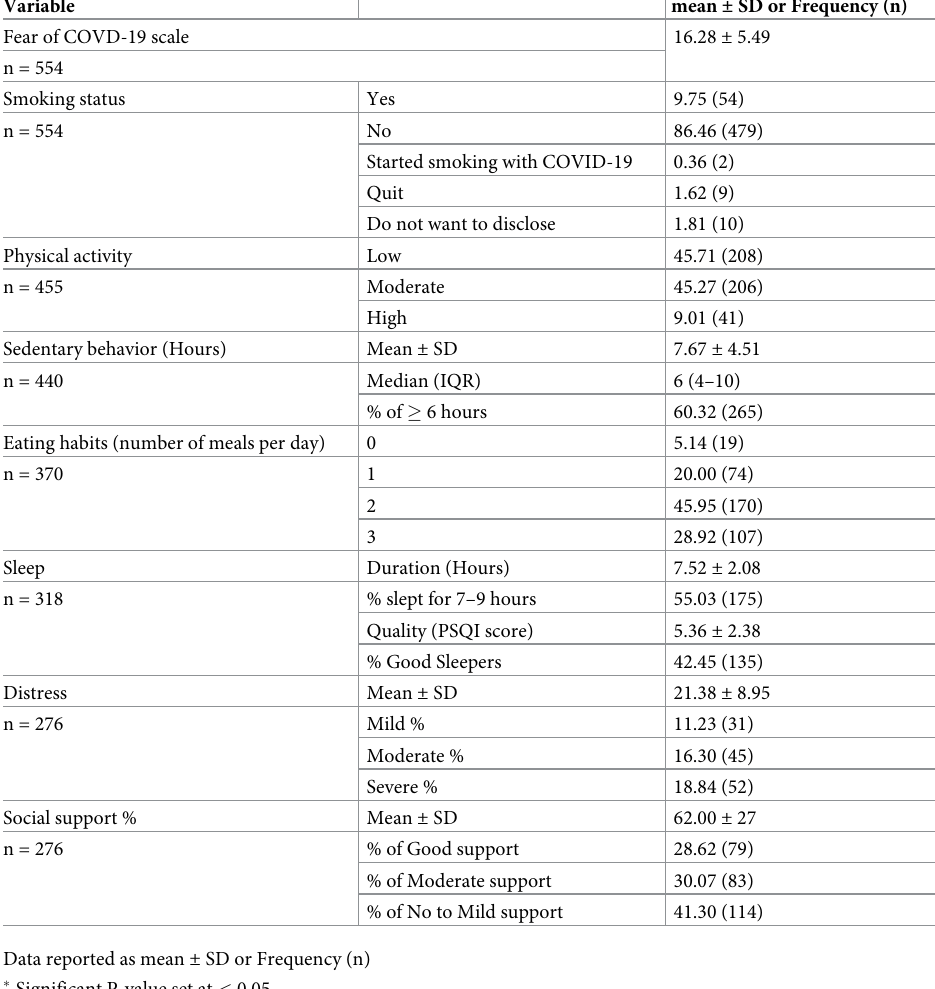
Significant P-value set at <